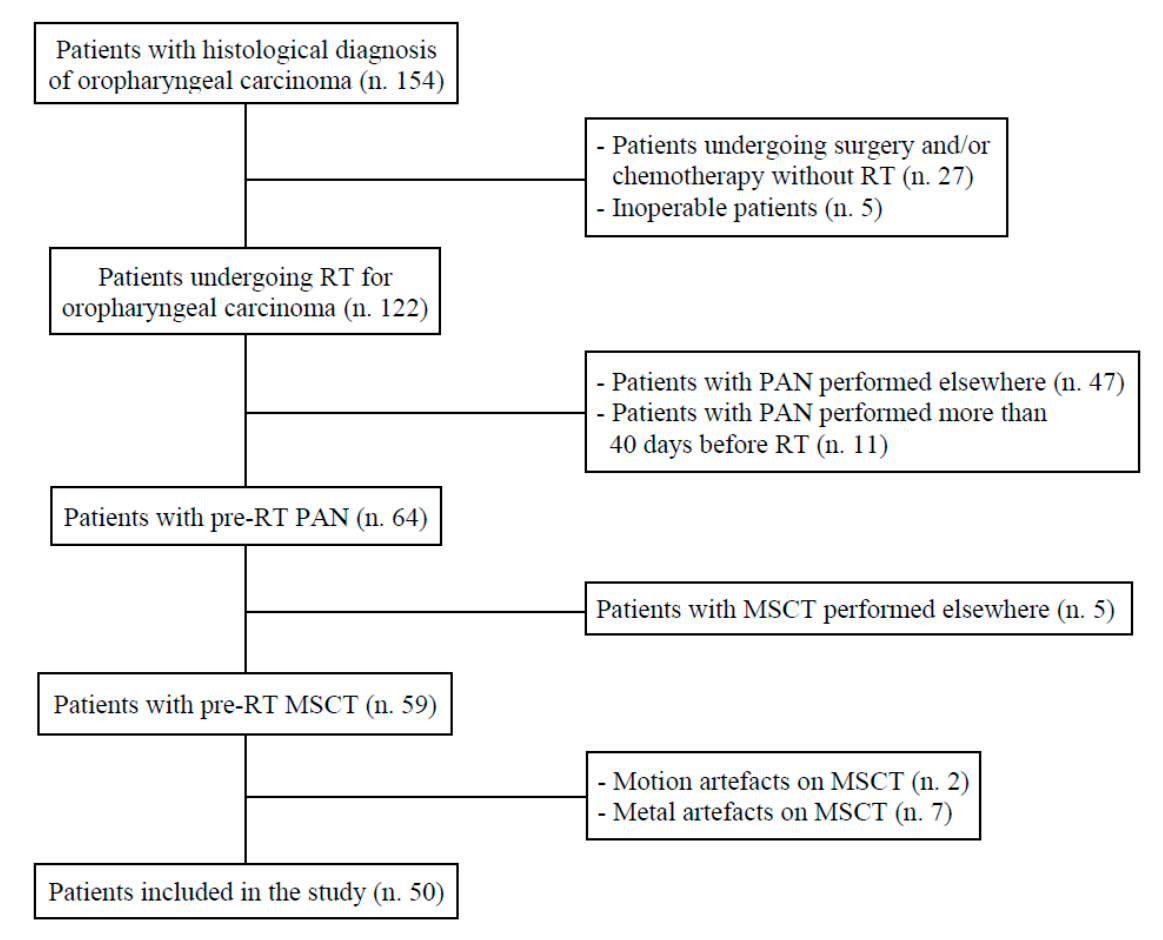
Figure 1. A flowchart of the selection criteria for enrolling patients. Radiotherapy (RT). Multislice Spiral Computed Tomography (MSCT). Panoramic radiography (PAN).